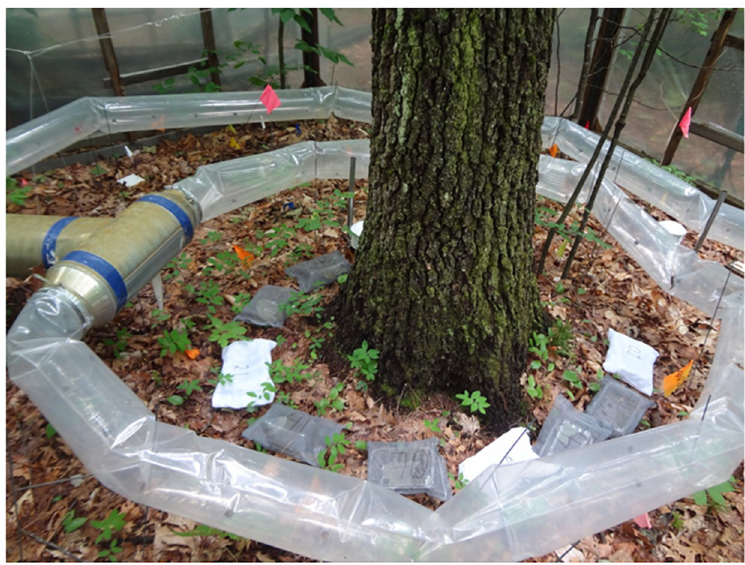
Fig 1. Litterbags placed in the Harvard Forest warming chambers. Different mesh sizes were used to control the size of the invertebrate community accessing the bags (‘invertebrate exclusion treatments’).